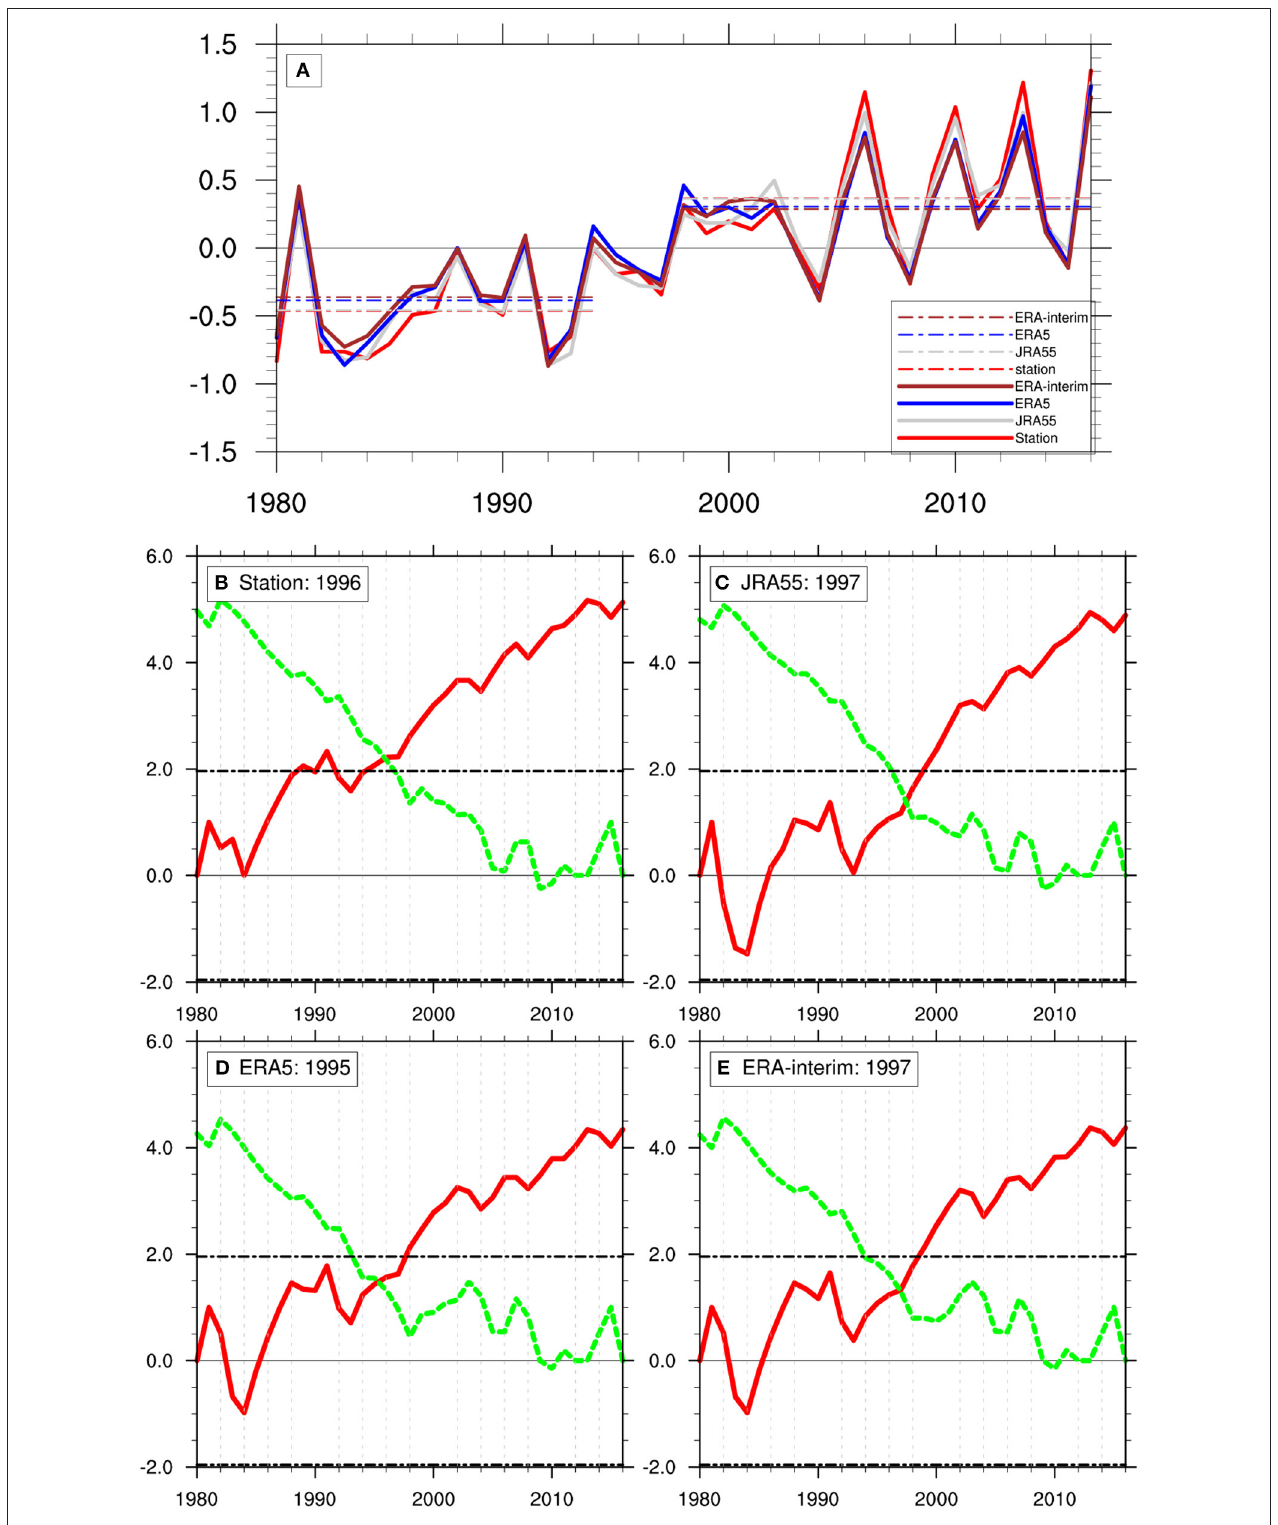
FIGURE 3 | (A) Temperature change in summer over the eastern part of the Tibetan Plateau region for 1980–1994 and 1998–2016. The solid lines are time series of Tibetan Plateau summer temperature during 1980–2016 for different datasets. The dashed lines represent the mean TPST for 1980–1994 and 1998–2016, respectively. Mann–Kendall regime shift test of the temperature over the eastern part of the Tibetan Plateau for (B) station, (C) JRA55, (D) ERA5, and (E) ERA–Interim. Red line represents the forward line; Green line represents the back line. All of them are statistically significant at the 95% confidence level.